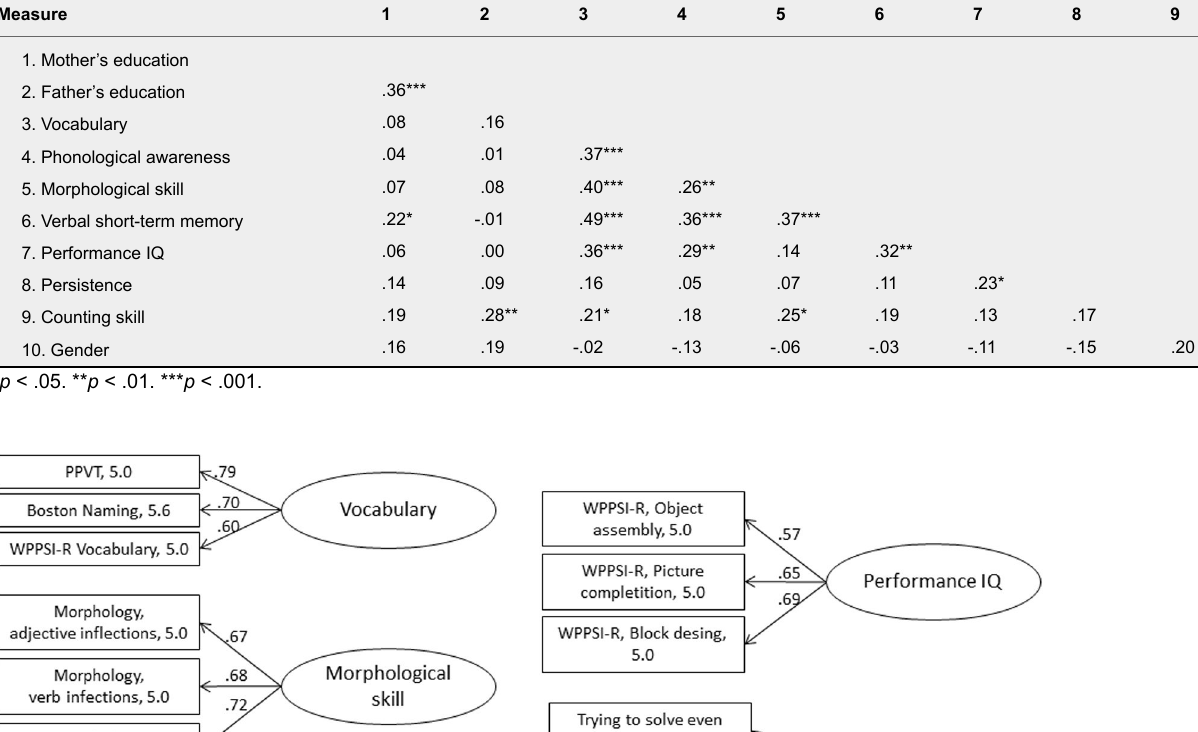
Correlations Between Parents’ Education, Children’s Cognitive Skills, Persistence, Gender, and Counting Skill Measure